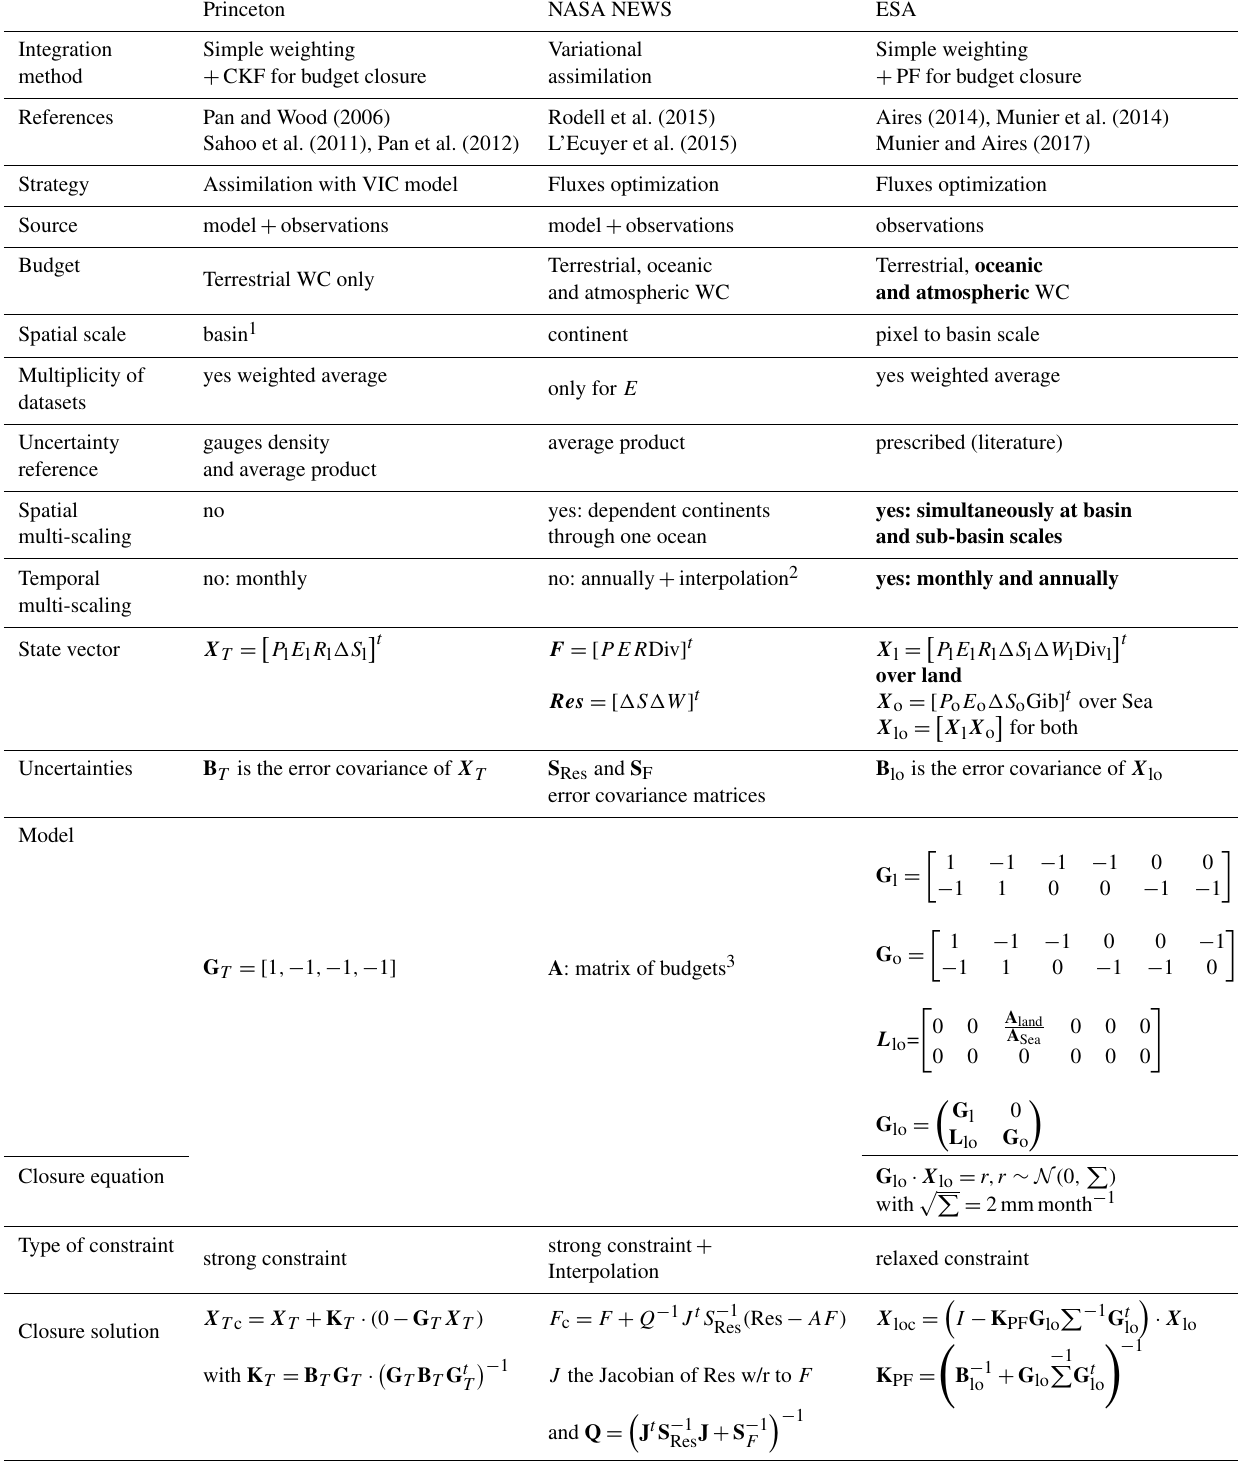
Table 1. The three main initiatives for budget closure constraint and their technical differences. (In the third column, bold font indicates the new features of the methodology presented in this article.) Subscripts are “l” for land and “o” for ocean; both include the atmosphere. All notations are summarized in Table A1. 1 Zhang et al. (2016) recently developed a WC-VIC assimilation scheme at the 0.5 ◦ pixel scale; 2 Rodell et al. (2015) used a two-step integration method with annual closure simply downscaled at the monthly scale, plus a Lagrange interpolation for closure relaxation; 3 see Rodell et al. (2015) for details and